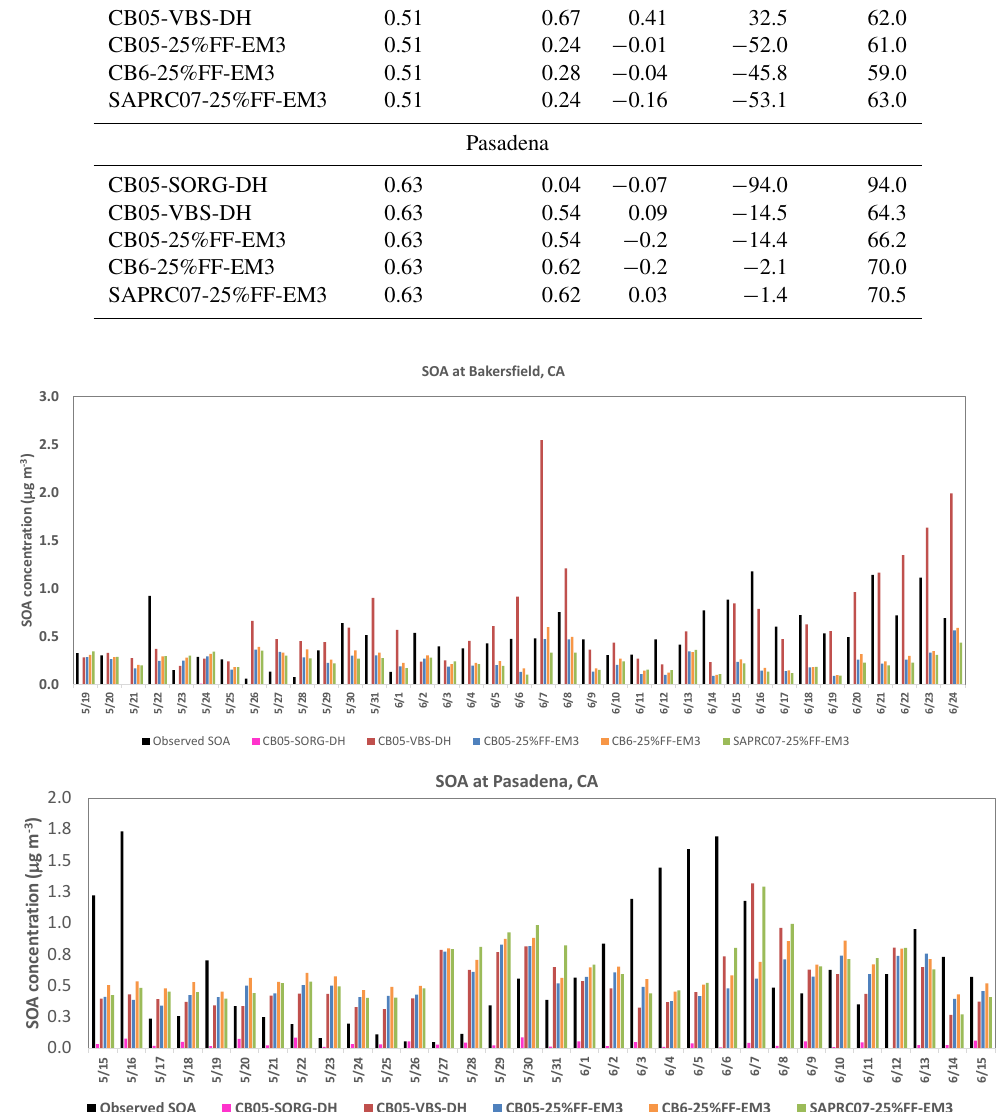
Figure 4. Comparison of obs SOA vs. sim SOA at CalNex sites in Bakersfield and Pasadena in